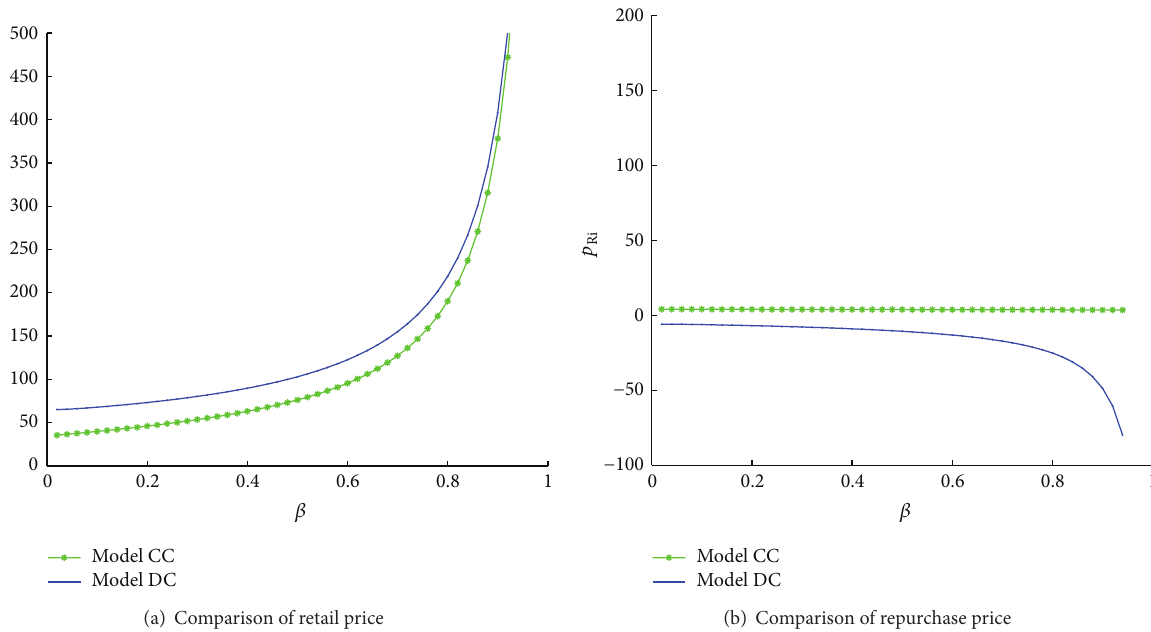
Figure 6: Pricing decisions of coordinated collection versus decentralized collection.